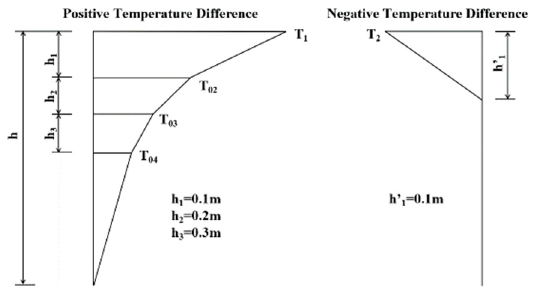
Figure 16. Temperature gradient model of unpaved steel box girder. Table 6. Values of temperature bases for different return periods of unpaved steel box girder.